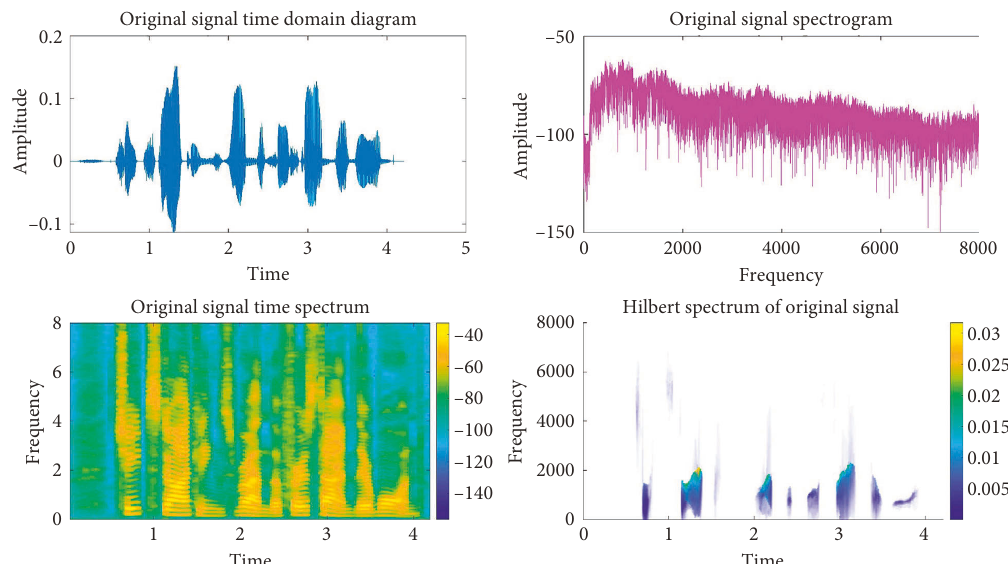
Figure 4: Time-frequency analysis of the original signal.